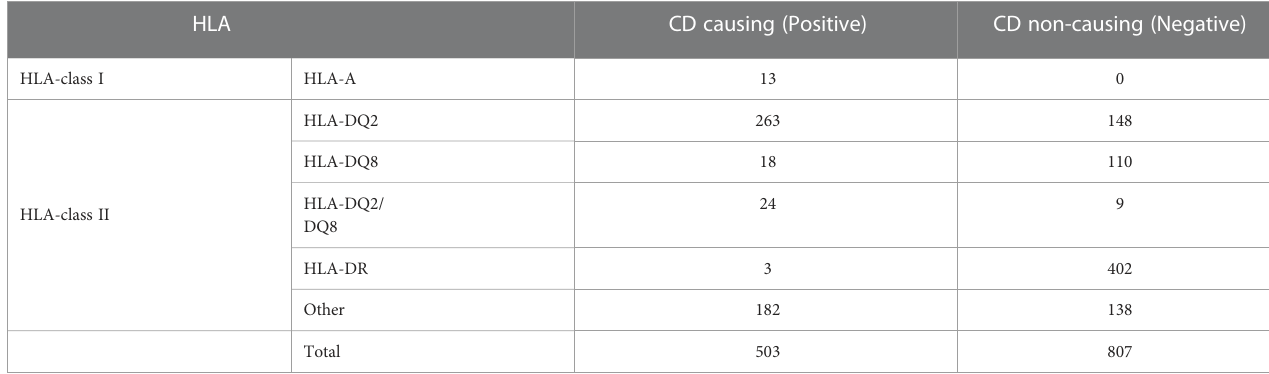
TABLE 1 Distribution of HLA alleles in CD causing and non-causing peptides.